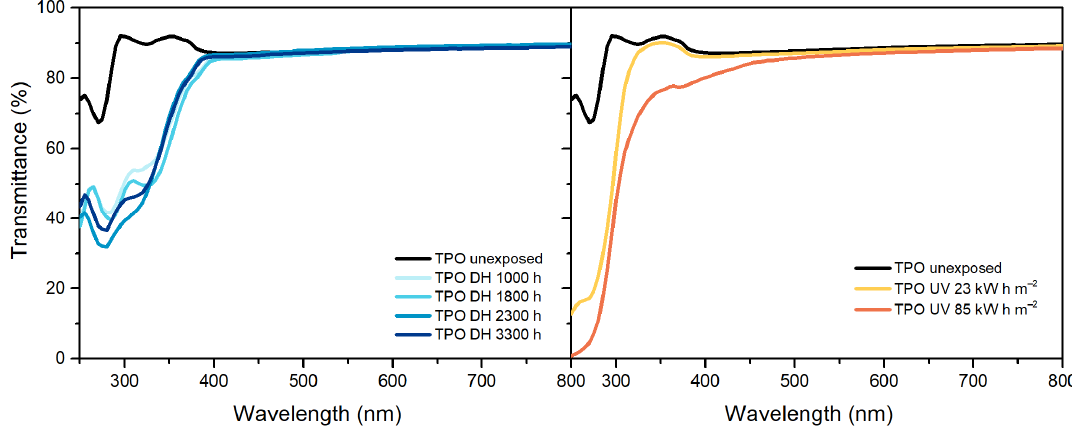
Figure 2. UV-Vis spectra of thermoplastic polyolefin (TPO) unexposed, exposed to DH (left) and UV test (right).